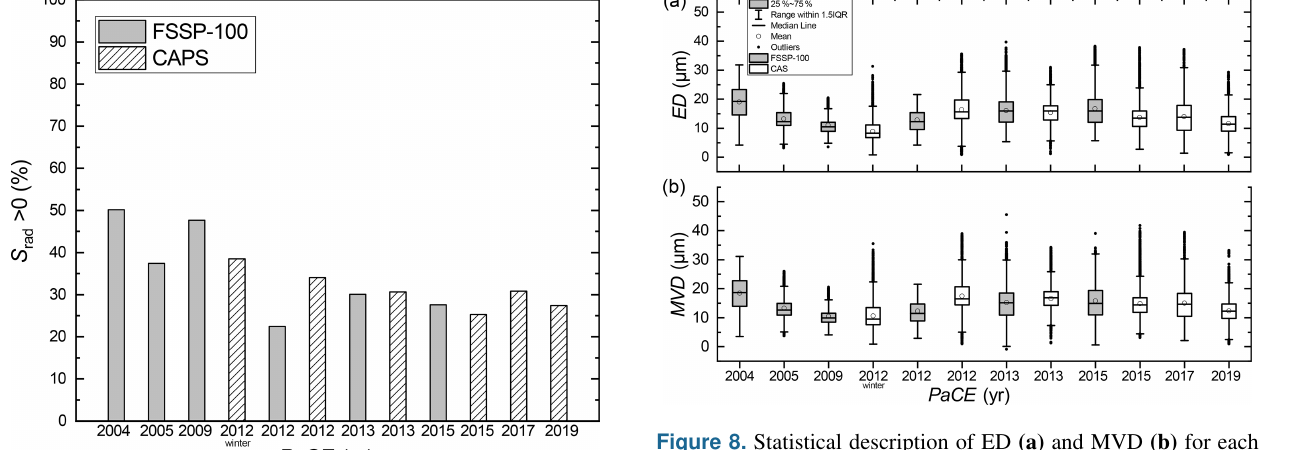
Figure 8. Statistical description of ED (a) and MVD (b) for each PACE campaign during which the FSSP-100 and CAS ground se- tups were operational.